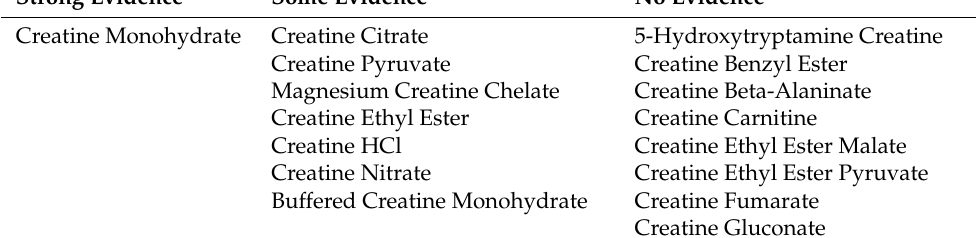
Table 7. Categorization of purported sources of creatine based on bioavailability, efficacy, and safety. Strong